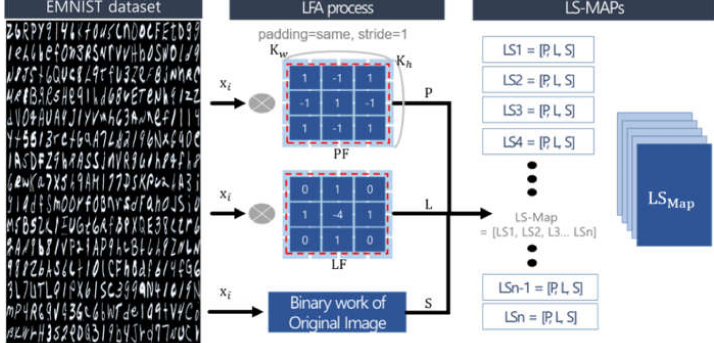
Figure 4. Feature extraction process of the line-segment feature algorithm